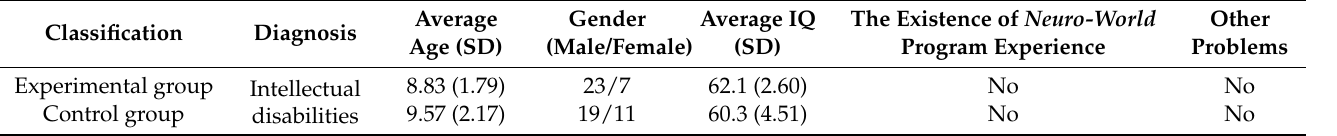
Table 1. Generic characteristics of the